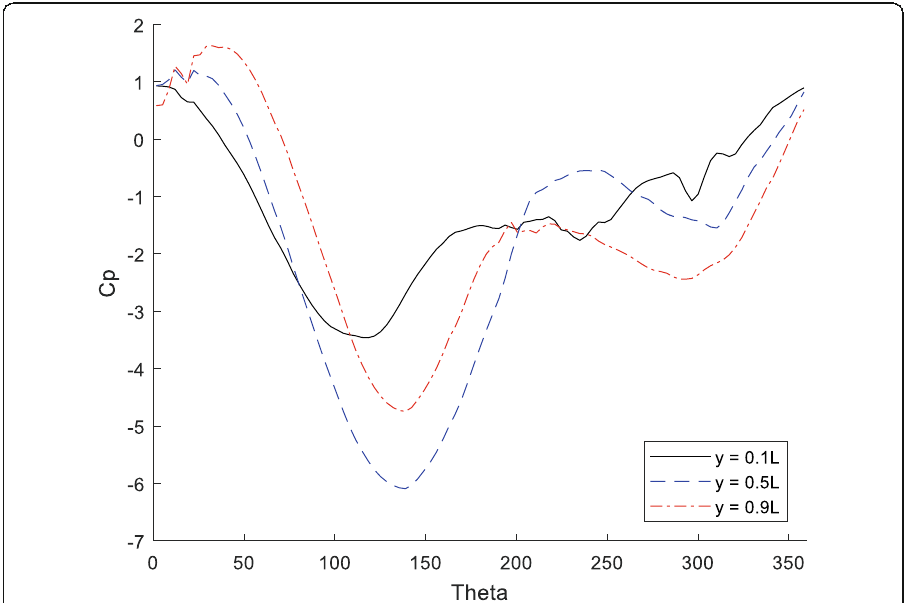
Fig. 11 Distribution of the pressure coefficient on the Magnus blade at different spanwise locations for AR =